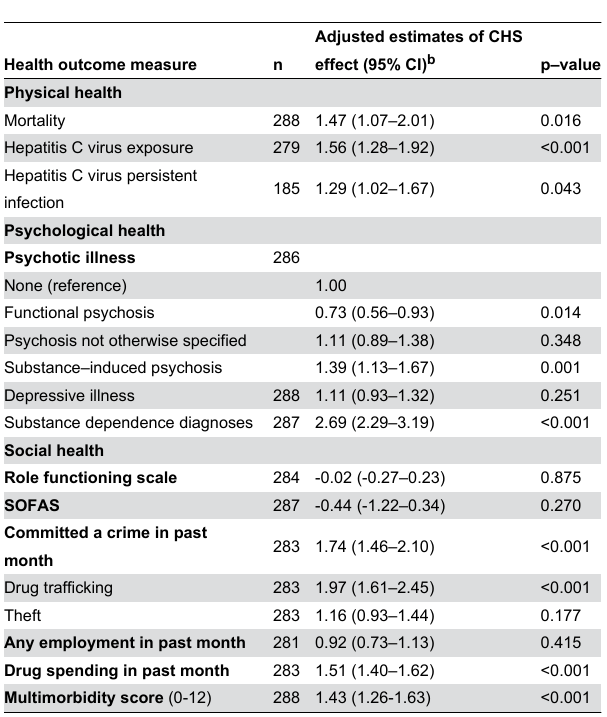
Table 3. Regression analysis of association between composite harm score and health outcome measures a